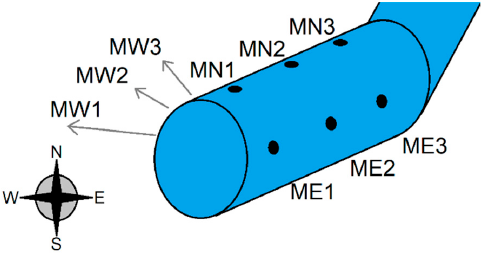
Figure 2. An example of the markers that were used to track the displacement of the sleeve. The markers were drawn onto the sleeves and labeled using cardinal directions with the convention MW1: “Marker West 1” and so forth. There was a total of nine markers on the sleeve, three on each side. The selection of the number and location of these markers were done based on two factors: (a)